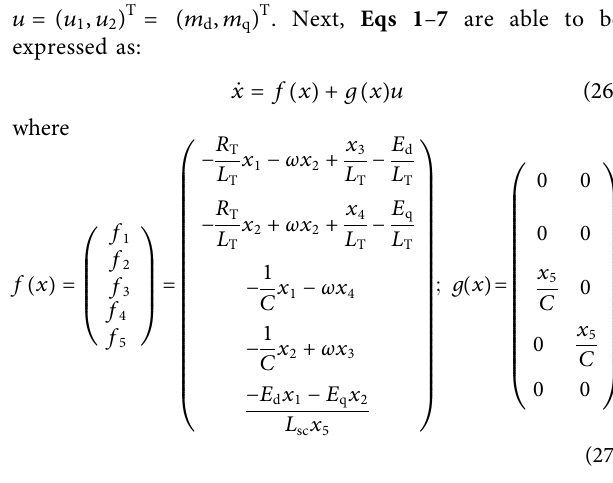
Frontiers in Energy Research |